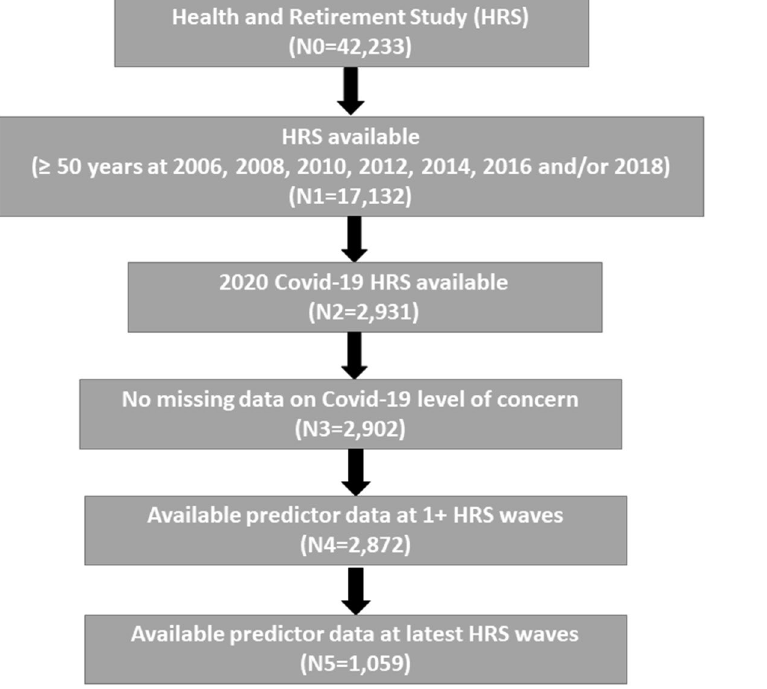
Figure 1. Study flowchart—2006–2020 health and retirement